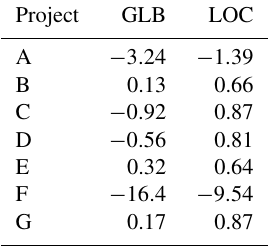
Table 6. Nash–Sutcliffe efficiency of daily river discharge simula- tions.